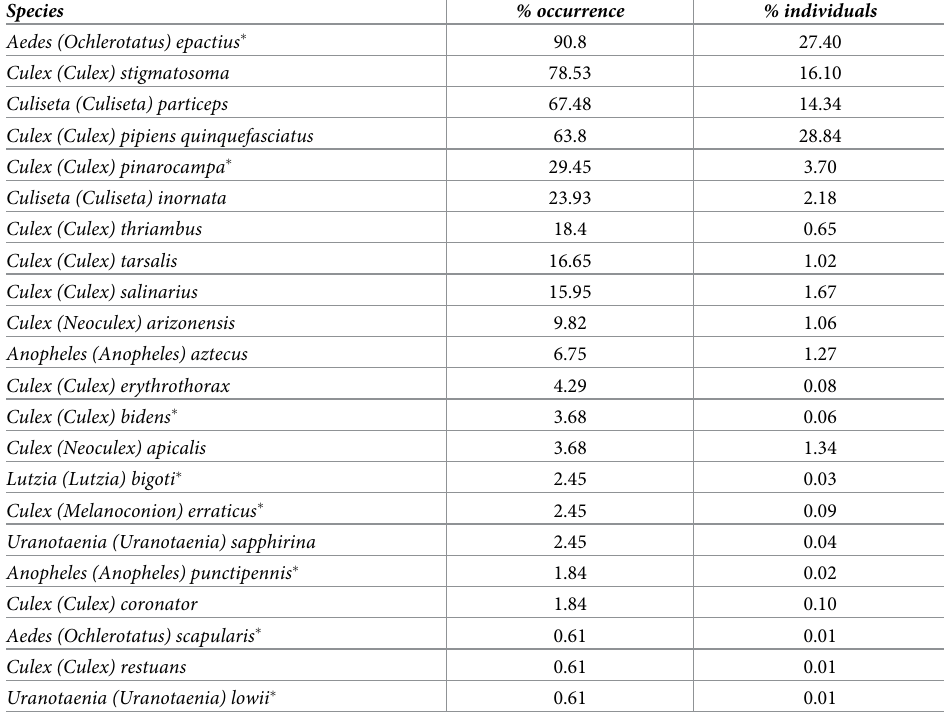
Culex (Culex) restuans 0.61 0.01 Uranotaenia (Uranotaenia) lowii � 0.61 0.01 � Species marked with asterisks are new records for Mexico